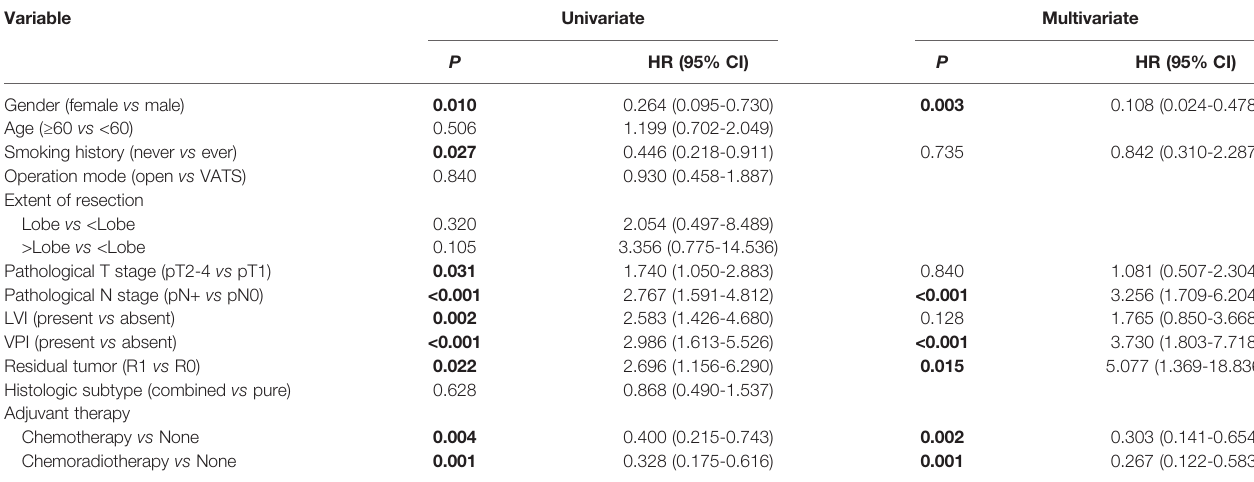
TABLE 2 | Cox regression analysis of factors associated with overall survival for surgically resected SCLC patients (n=153). Variable